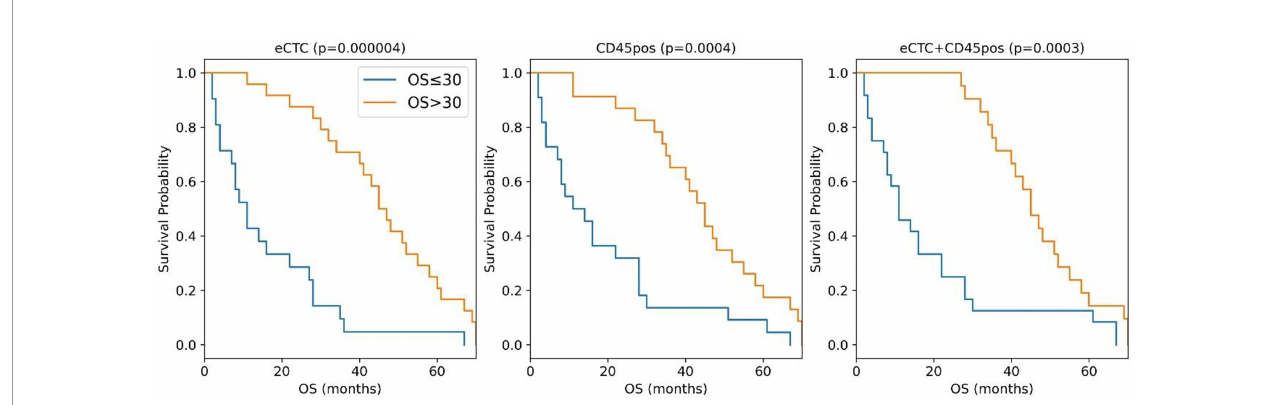
FIGURE 3 | Kaplan – Meier curves of the MBC patients strati fi ed in OS <= 30 months (blue curve) or >30 months (orange curves) according to the naïve Bayes analysis conducted taking into consideration eCTC (left panel), CD45pos (central panel) or eCTC+C45pos (right